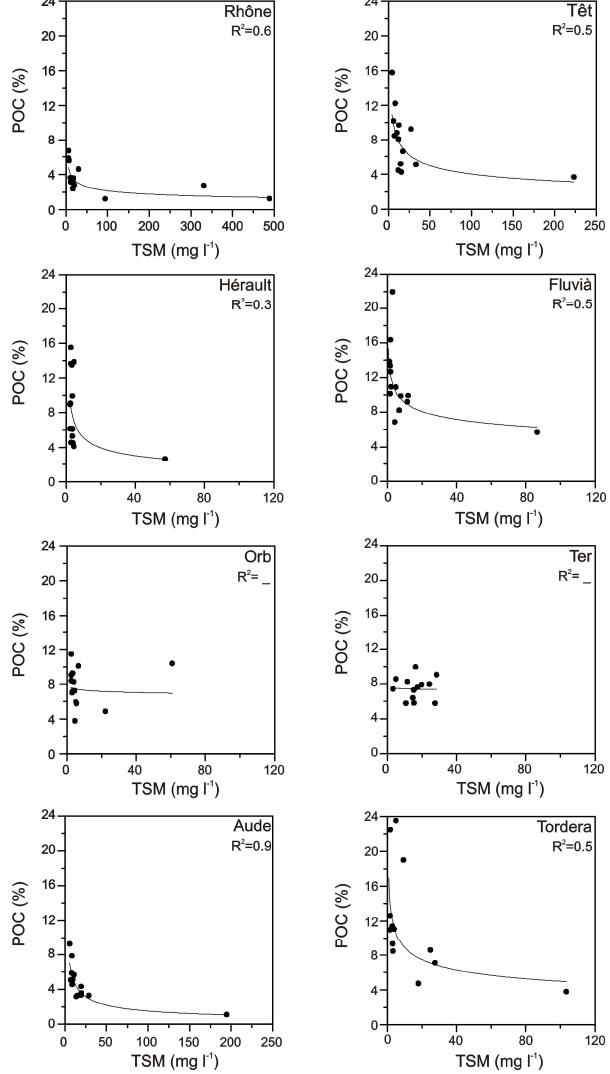
Fig. 6. Relationships between total suspended matter (TSM) con- Figure 6. Relationships between total suspended matter (TSM) concentration and particulate 856 centration and particulate organic carbon (POC) contents (in per- organic carbon (POC) contents (in percentage) with R 2 values obtained using the power 857 centage) with R 2 values obtained using the power equation: POC% = a × TSM b , where a and b are regression equation: POC% = a·TSM b , where a and b are regression coefficients. 858